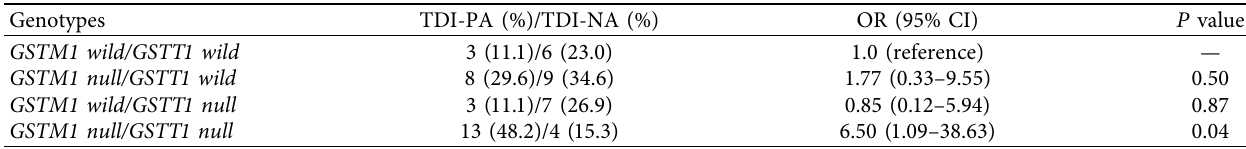
Table 3: Combined analysis of GSTM1 and GSTT1 mutant frequencies according to the response of the TDI challenge.